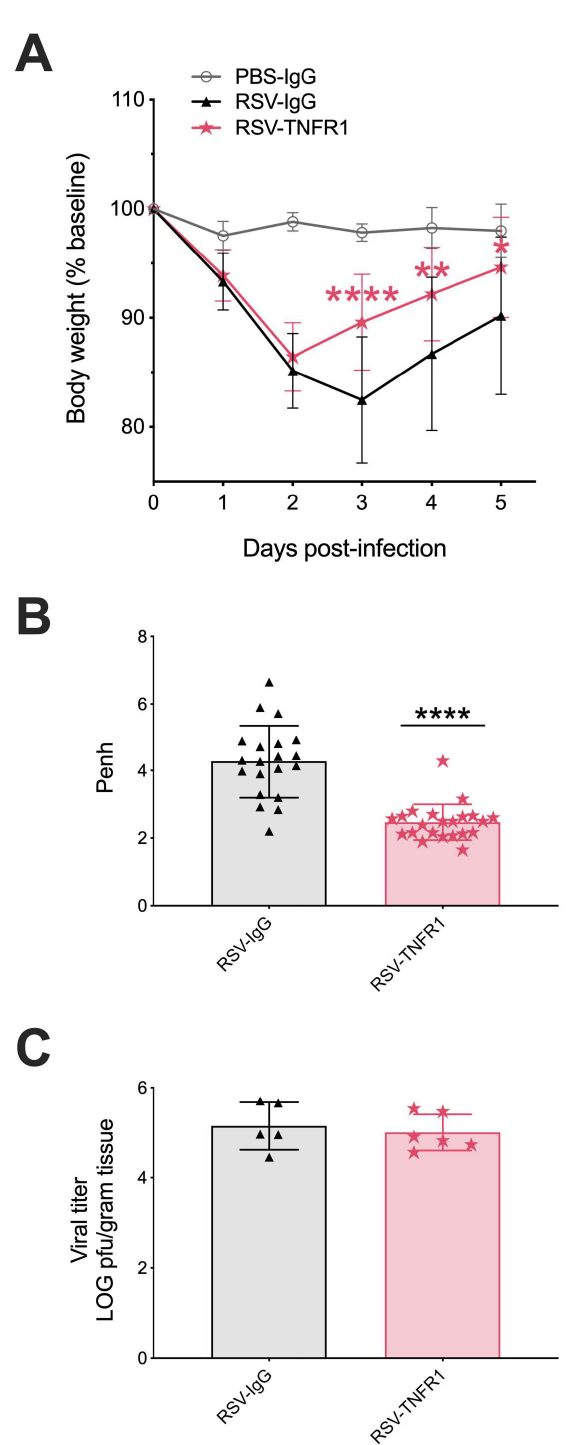
1 Figure 7. Post-infection blockade of TNFR1 improves clinical disease and bronchoconstriction in RSV infected mice. Mice were monitored over the five-day infection period for changes in ( A ) body weight as an indicator of clinical disease. On day one p.i., ( B ) bronchoconstriction, represented by baseline Penh, was assessed by unrestrained plethysmography. Lung tissue collected at day five p.i. was measured for ( C ) viral titer using lung homogenate in a viral plaque assay. Data are pooled from three independent experiments and expressed as mean ± SD. Significant results as compared to the respective control are marked with asterisks (* for p ≤ 0.05, ** p ≤ 0.01, **** p ≤